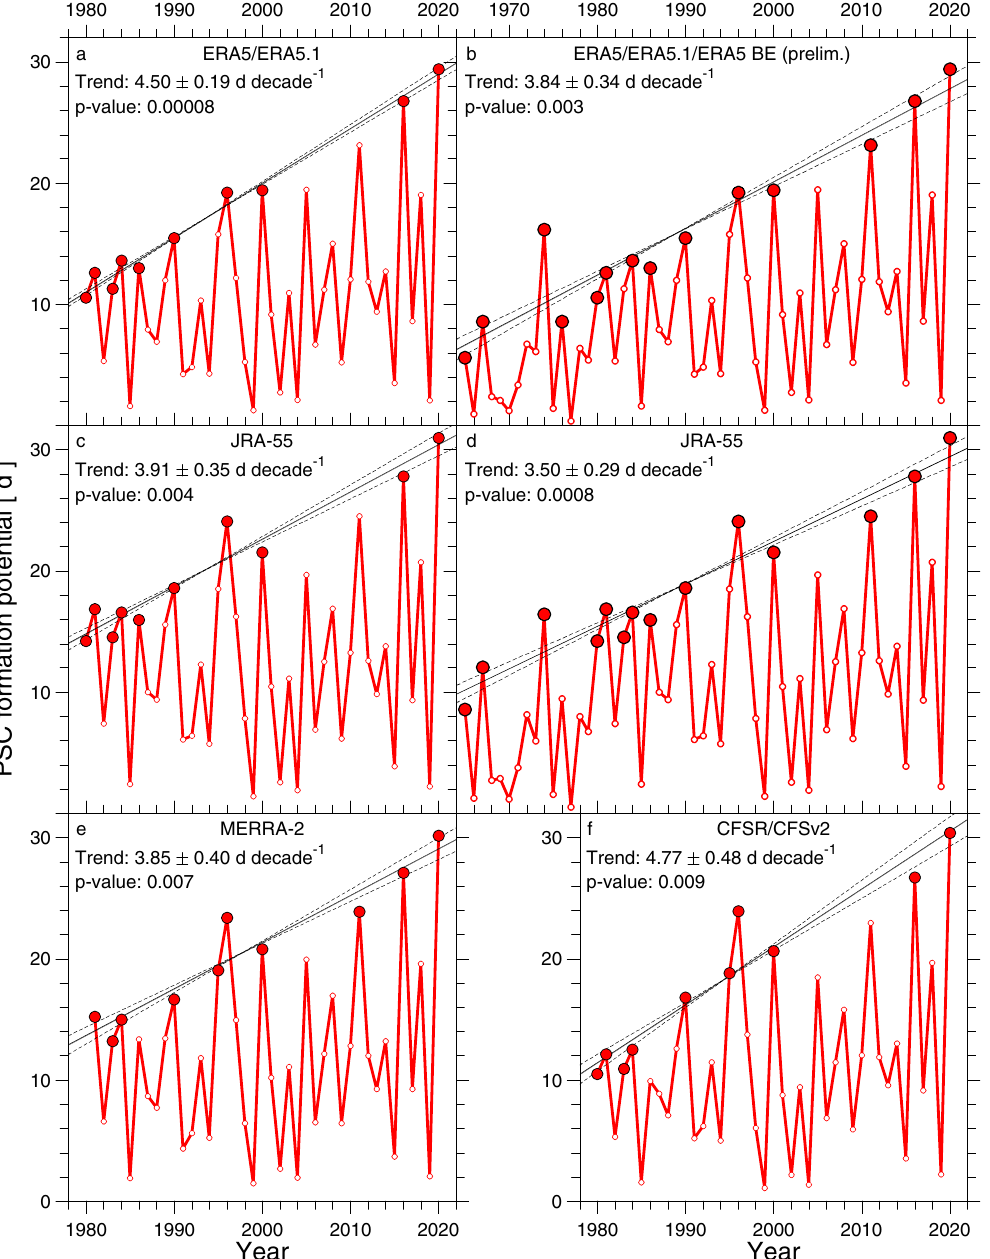
Fig. 3 PFP as a function of time. a – f Time series of PSC formation potential (PFP) for reanalysis data from: ERA5/ERA5.1 from 1980 to 2020 ( a ) and ERA5/ERA5.1 combined with the ERA5 back extension (BE) (preliminary version) from 1965 to 2020 ( b ); JRA-55 from 1980 to 2020 ( c ) and from 1965 to 2020 ( d ); MERRA-2 from 1981 to 2020 ( e ); CFSR/CFSv1 from 1980 to 2020 ( f ). The solid red circles indicate the coldest winters in the record selected using the ISA trend detection procedure (see “ Methods ” ). A linear, least-squares fi t (solid line) and 1 σ uncertainty of the fi t (dashed lines) to the solid red circles are shown in each panel, along with numerical values of the slopes ( S PFP − LM ), the 1 σ uncertainties of these fi ts ( Δ S PFP − LM ), as well as p -values for the quantity S PFP − LM / Δ S PFP − LM (last column, Table